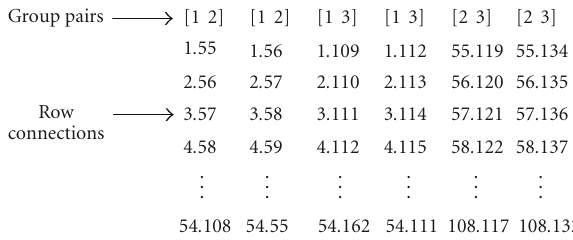
Figure 8: Group row connections forming girth-sixteen LDPC code with row-weight of